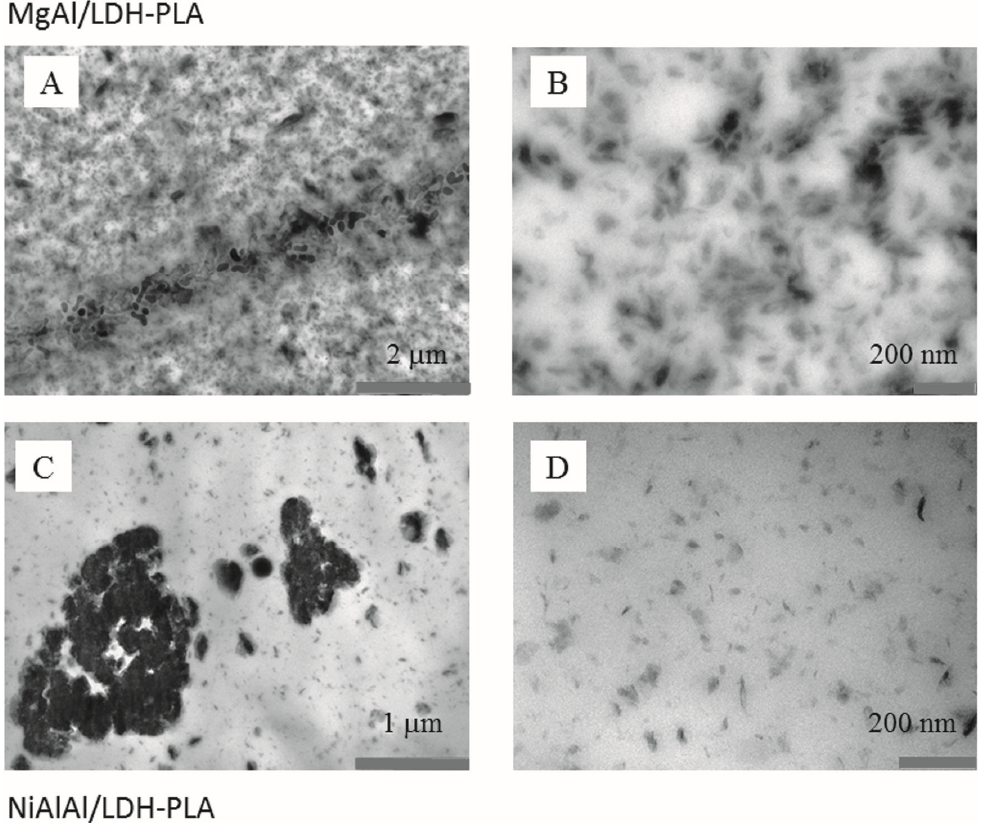
Figure 2. TEM picture for nanocomposites with an LDH concentration of 3 wt.%. ( A ) MgAl/LDH– PLA size bare 2 µm; ( B ) MgAl/LDH–PLA size bare 200 nm; ( C ) NiAl/LDH–PLA size bare 1 µm; ( D ) NiAl/LDH–PLA size bare 200 nm [62]. Adapted from Leng, J.; Kang, N.; De-Yi, W.; Falkenhagen, J.;